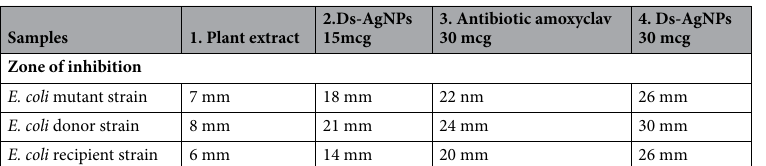
Table 2. Antibacterial activity of Ds-AgNPs on antibiotic resistant E. coli.